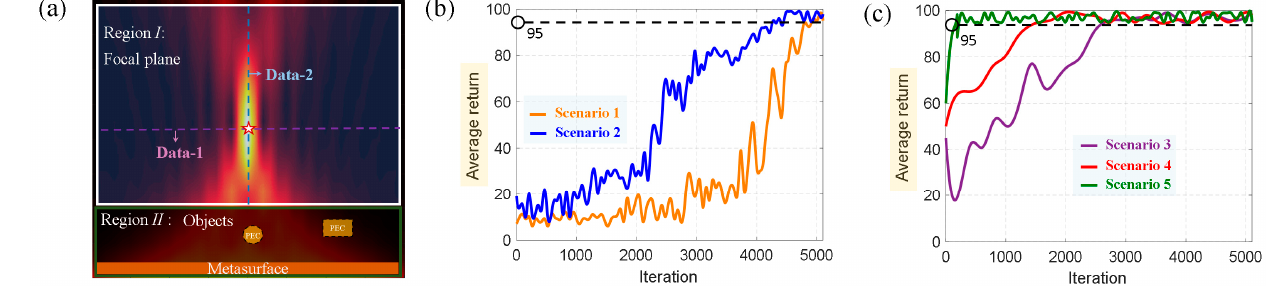
Figure 4. ( a ) Schematic illustration of focal plane and selection of training data. ( b ) Average returns for Scenarios 1 and 2. ( c ) Average returns for Scenarios 3, 4, and 5.